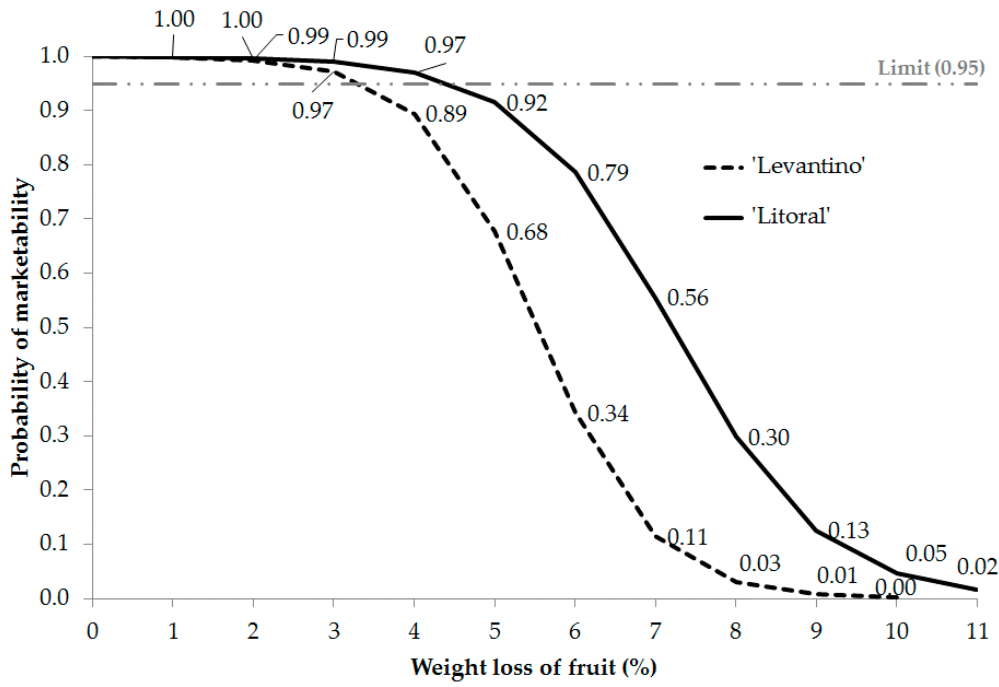
Figure 8. Probability of marketability based on fruit loss percentage during storage for the Levantino and Litoral cultivars.